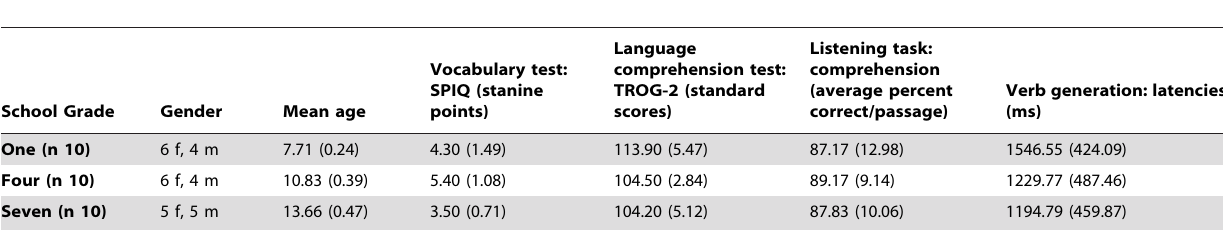
Table 2. Group composition and means and standard deviations on the language screening tests –vocabulary and language comprehension– and on the listening- and verb generation